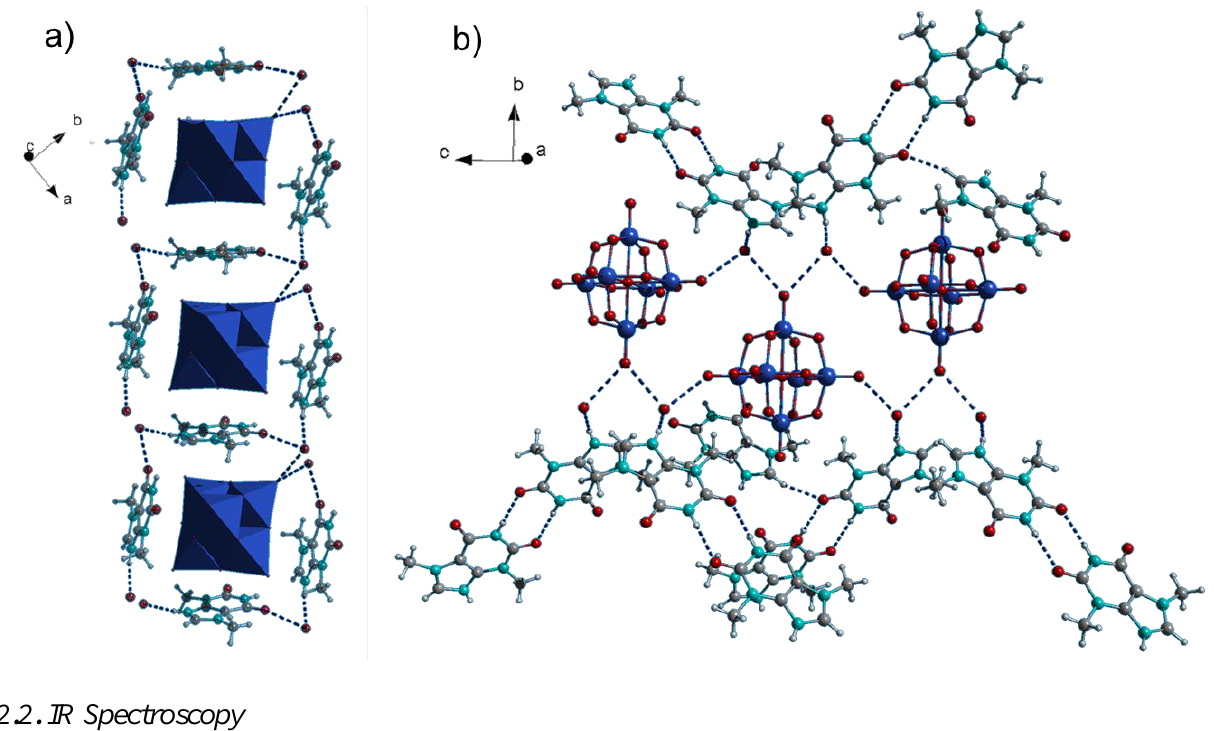
[W O ](H O) ( 3 ). ( a ) Molecular boxes of 2 6 19 2 2